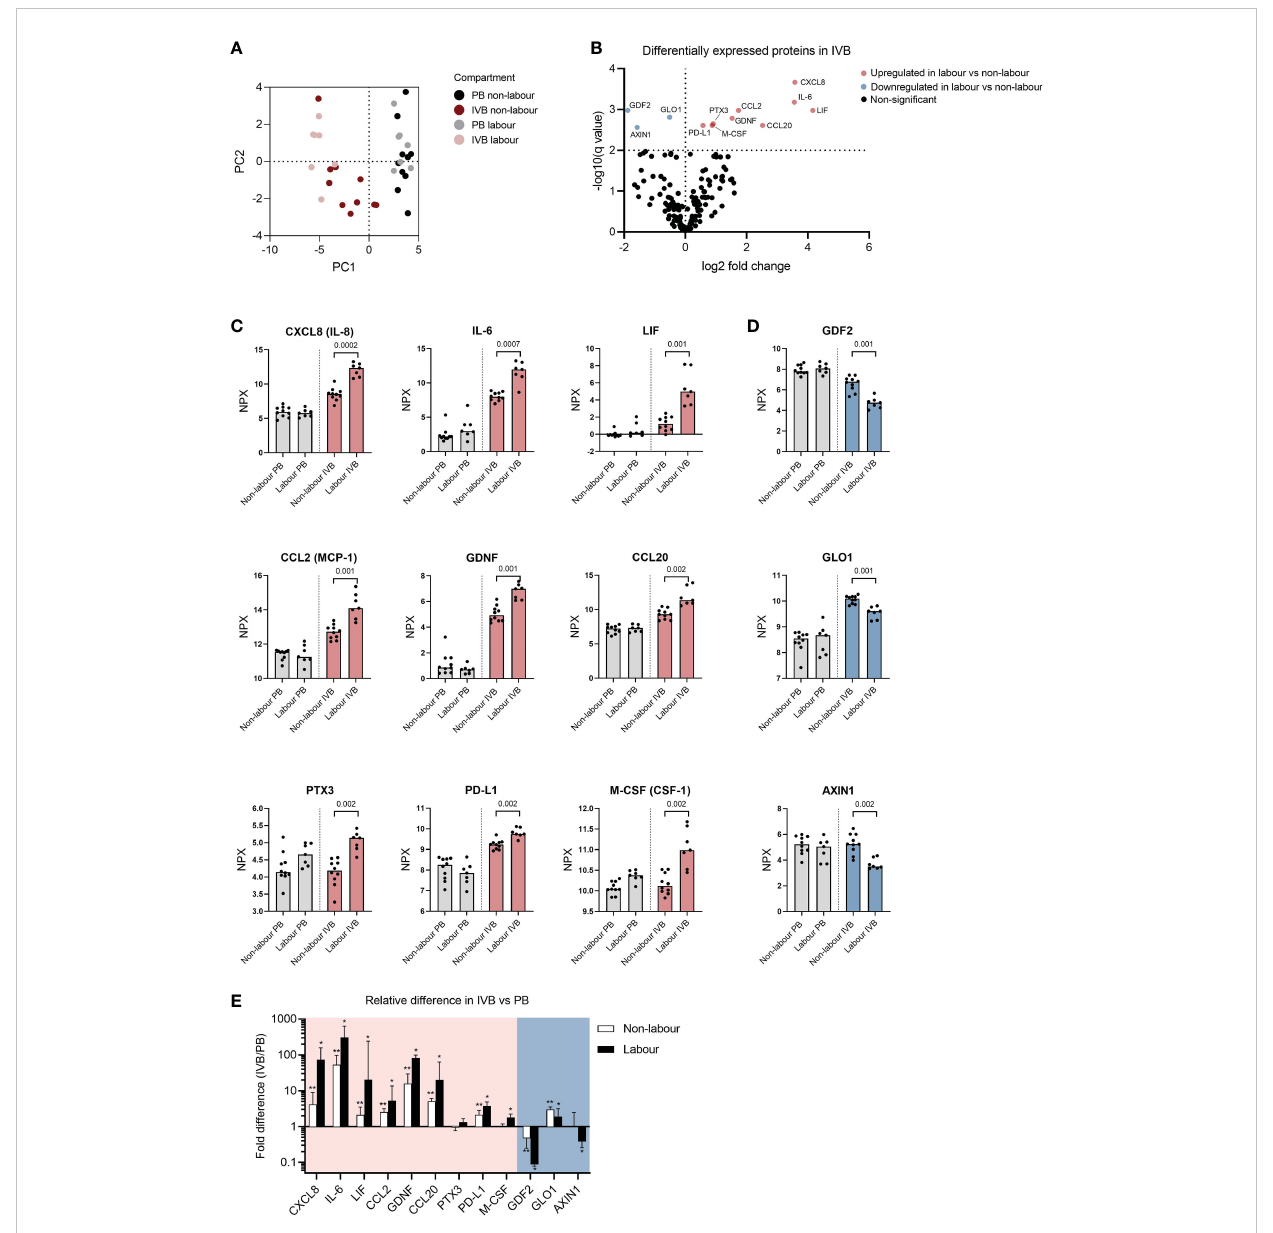
FIGURE 6 Proteomic analysis of intervillous blood plasma reveals differently expressed proteins in labour versus non-labour. (A) Principal component analysis (PCA) based on 166 plasma proteins from peripheral blood (PB) and intervillous blood (IVB) from women in labour (n=7) or without labour (n=10). (B) Volcano plot showing differentially expressed proteins in IVB plasma from women in labour vs women not in labour. (C) Up-regulated or (D) down-regulated proteins in plasma from labour or non-labour IVB. Data are expressed as normalised protein eXpression (NPX) values, which are in a Log2 NPX scale. Statistical differences were determined with a multiple unpaired t-test, with false discovery rate to correct for multiple comparisons. q values for signi fi cant differences between labour and non-labour are displayed in (C, D) . (E) Fold differences in protein levels based on data converted to linear scale between PB and IVB (ratio IVB/PB). Red and blue backgrounds depict proteins that were upregulated or downregulated in labour compared to non-labour, respectively. Data in (E) is presented as median and interquartile range and statistical differences were determined with Wilcoxon signed ranked test, *p<0.05,